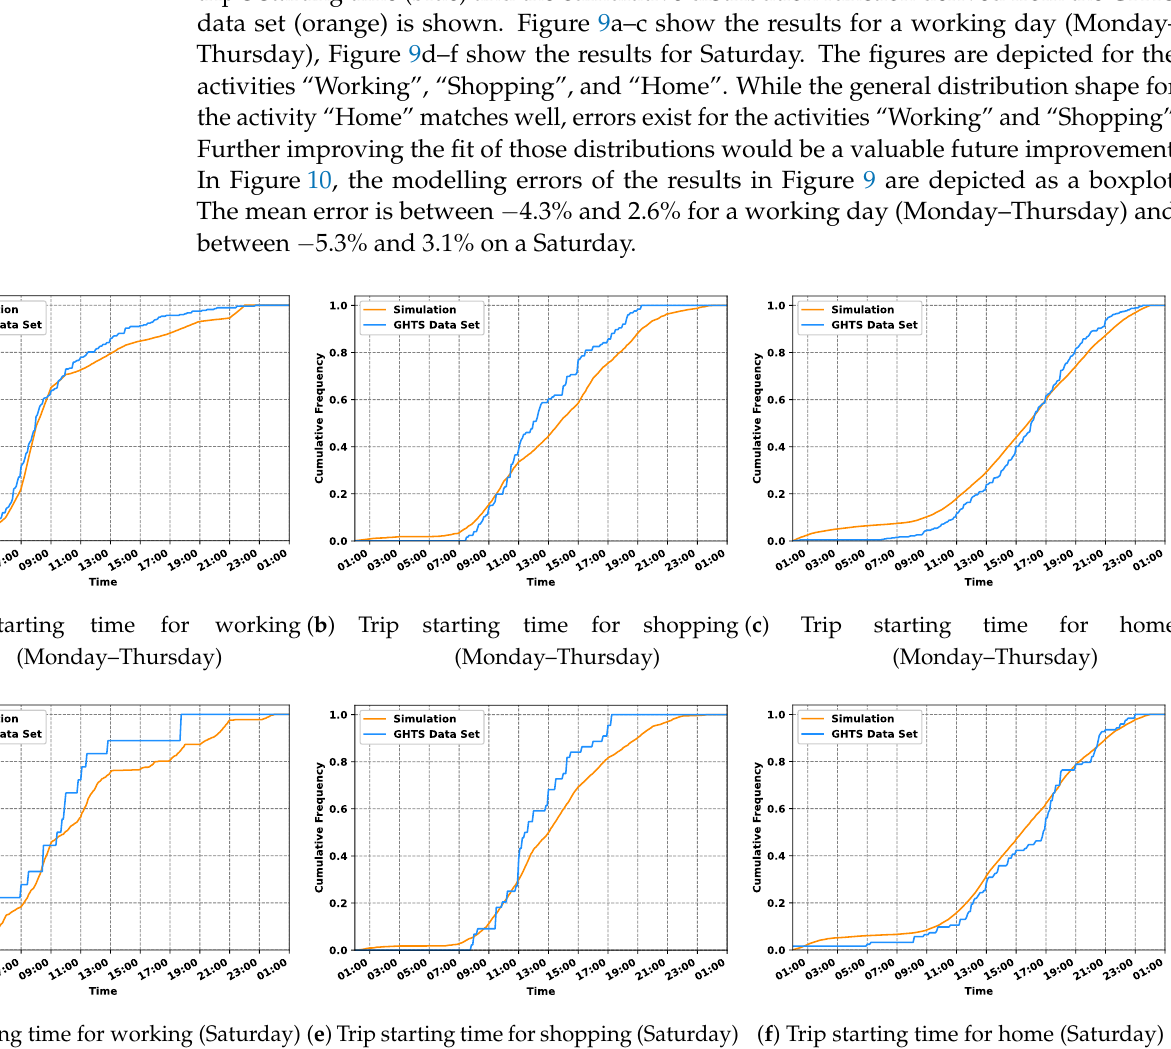
Figure 9. Cumulative distribution function for trip starting time—simulation and GHTS data set